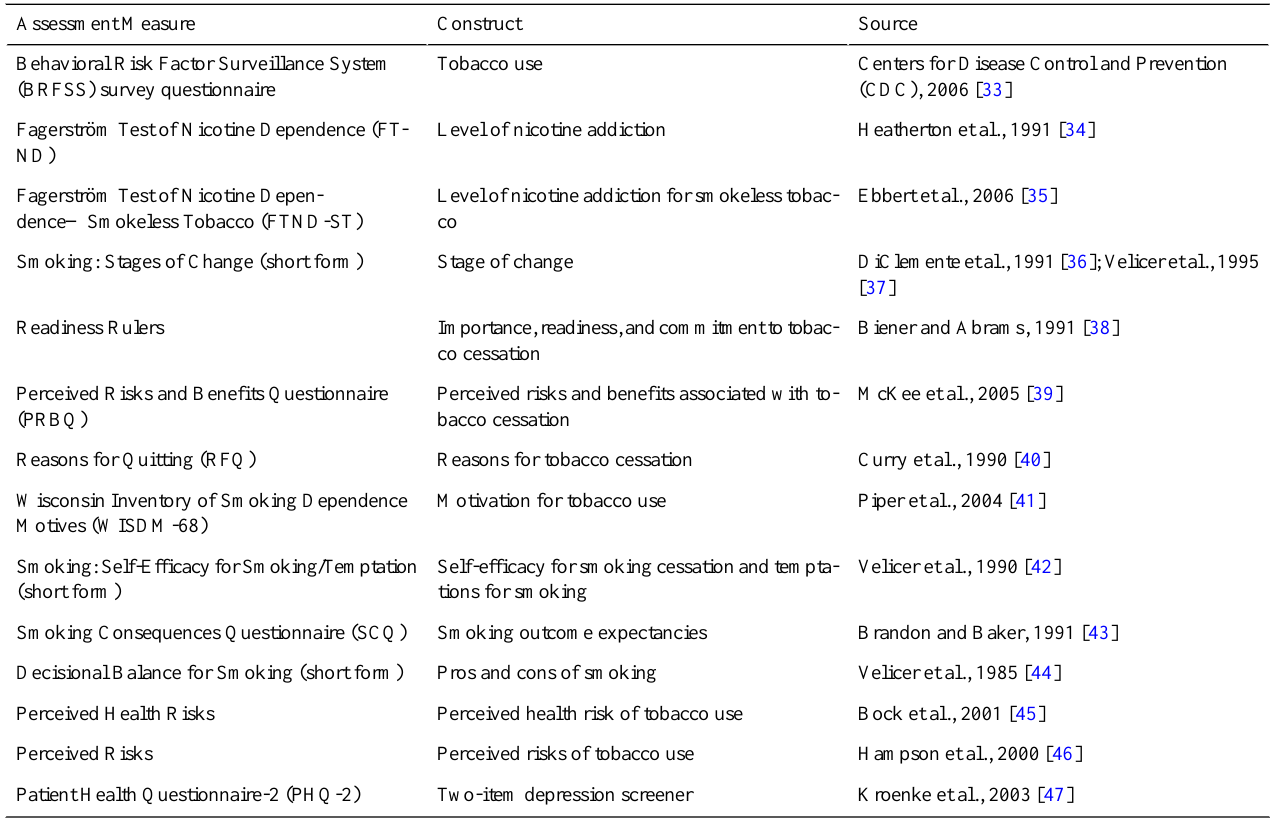
Table 1. Assessment measures used or adapted for the